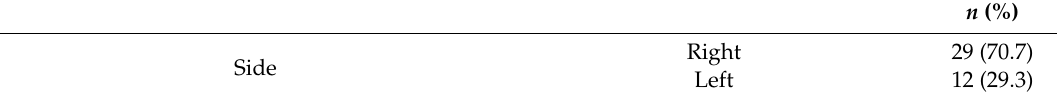
Table 1. Clinical features of patients.